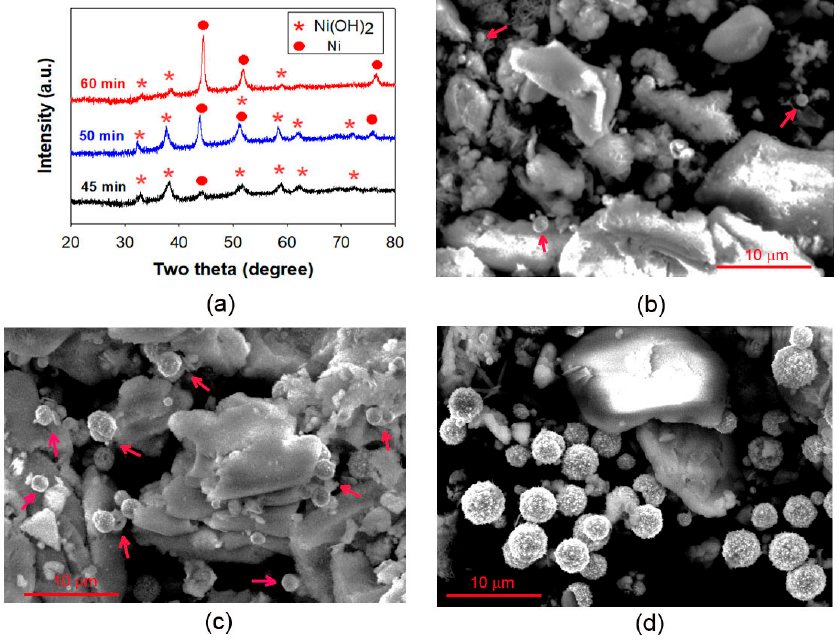
Figure 9. XRD ( a ) and SEM images ( c , d ) of the products formed in 200 mL of 15 M NaOH solution containing 3 mL of EDA after different reaction times: ( b ) 45 min, ( c ) 50 min, and ( d ) 60 min.